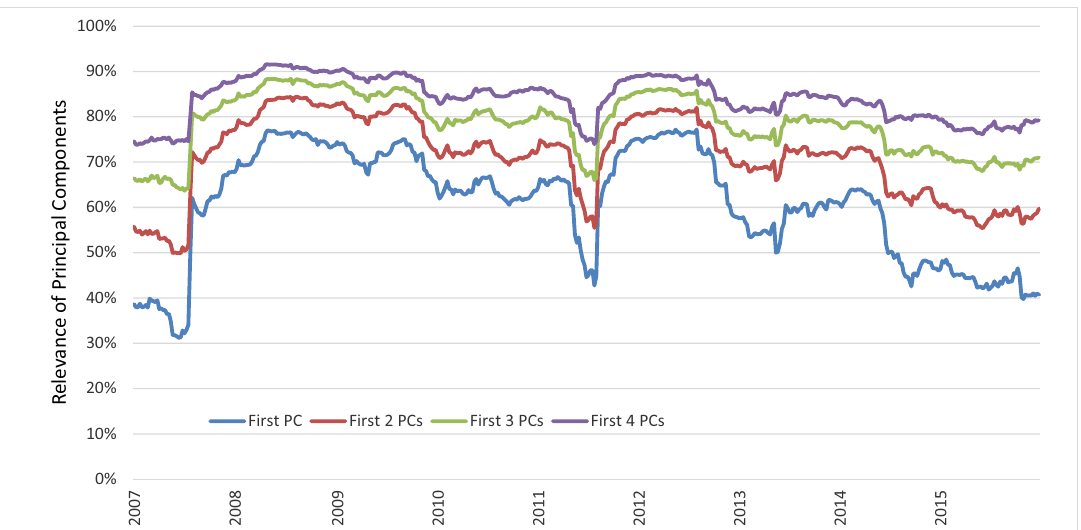
Figure 2. Cumulative information content in the first four principal components of sectorial returns. Weekly data: January 2007–December 2015. The figure shows the percent variance of the set of sectorial credit returns that is explained by the first k principal components of sectorial credit indices, k = 1, 2, 3,